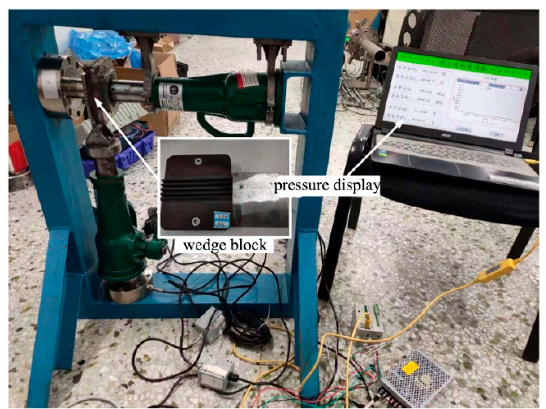
Figure 13. Equivalent friction coefficient test device.